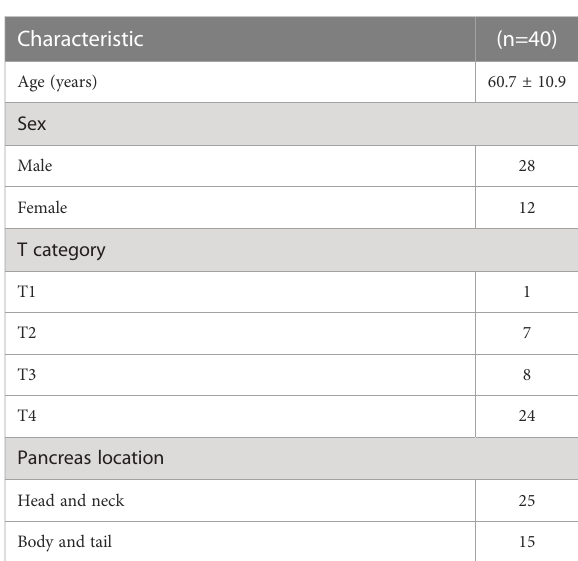
TABLE 1 Patient